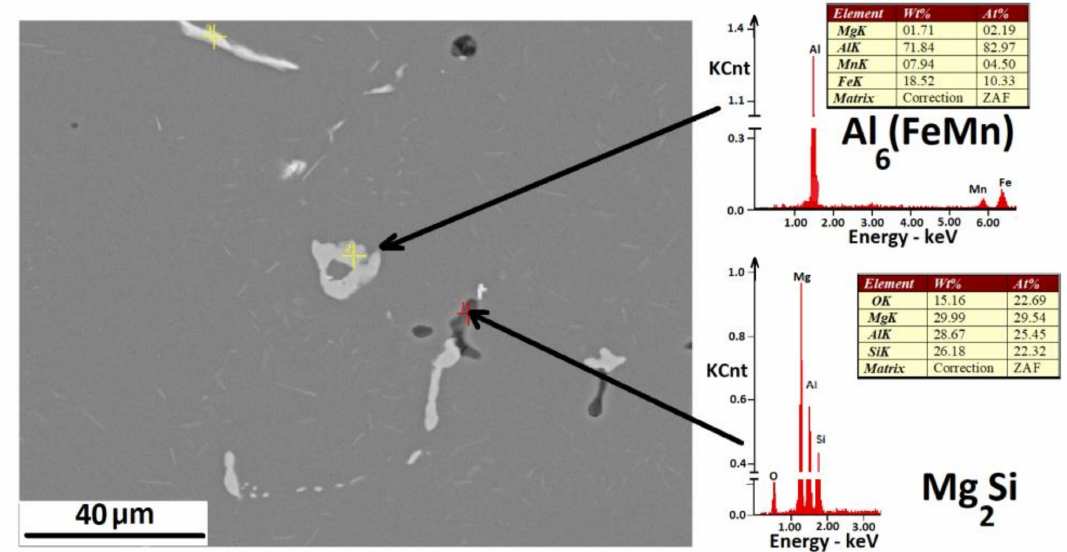
Figure 9. Chemical composition of the large intermetallic particles of the minor phase in 5182 alloys.